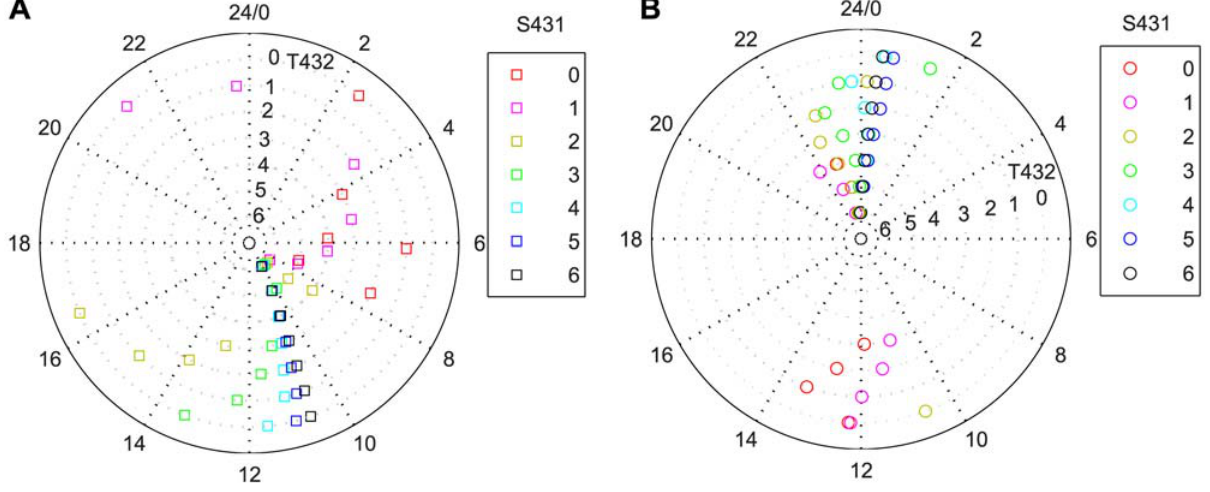
Figure 6. Phase distributions of hexameric KaiC phosphoforms in one circadian period. The time of minimum Y (the overall fractional saturation of phosphates) is taken as the zero time point of one circadian period. The sample are 49 KaiC phosphoforms defined by [C t s ] tot ; [LC t s ] + [LBC t s ]. These 49 point are identified by colors (as s , the numbers of phosphorylated S431) and radiuses (as t , the numbers of phosphorylated T432) in the diagram. The phase of each phosphoforms is defined in two ways: first, by the time of maximum [C t s ] tot in one circadian cycle (A); the other by the time of minimum [C t s ] tot (B).